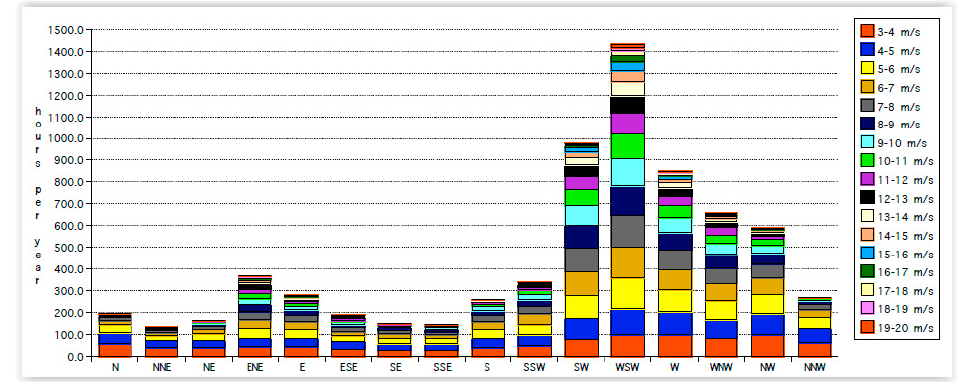
Figure 11. The yearly hour’s wind blows from different directions at different speeds. Figure 11 can be replotted, showing wind directions in different wind speeds, as shown in Figure 12.